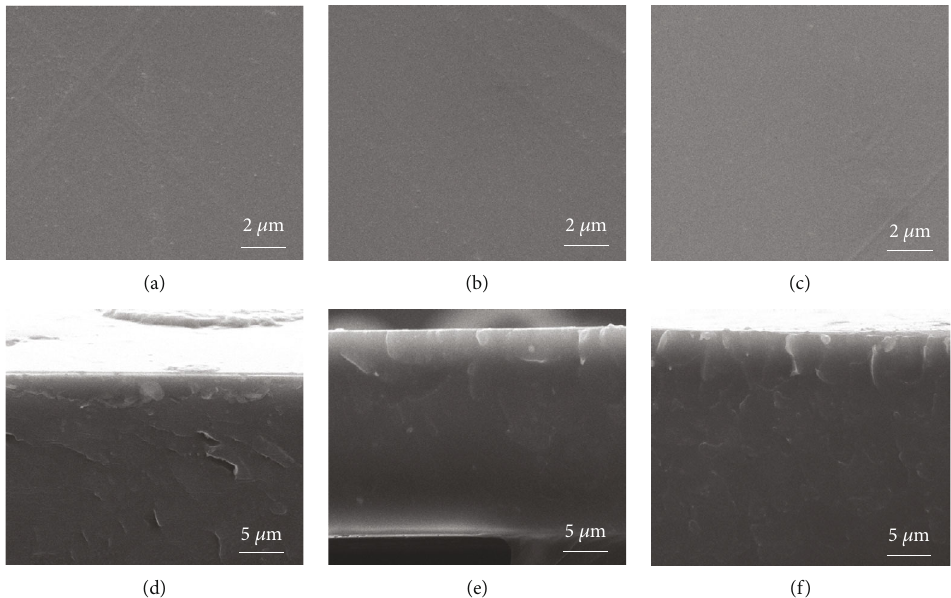
Figure 5: SEM micrographs of the surface (up) and cross-section (down) of PA-undoped membranes: (a, d) PBI, (b, e) PAEK- cr -PBI, and (c, f) PAEK- cr